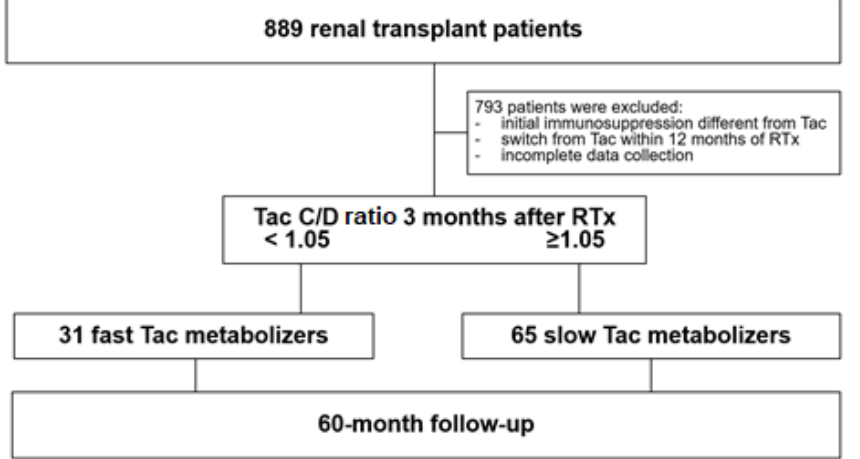
Figure 1. Study design and patient enrollment. Initially, a total of 889 renal transplant recipients were screened, but 793 patients were excluded because they did not meet the inclusion criteria. RTx recipients were defined as fast and slow Tac metabolizers 3 months after transplantation, and survival was observed in a 60-month follow-up. Abbreviations: Tac, tacrolimus; RTx, renal transplantation. C/D ratio values in ng/mL·1/mg.